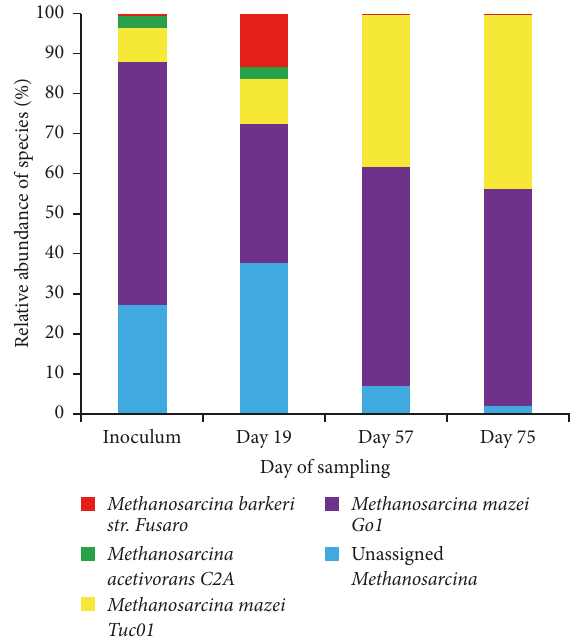
Figure 7: Dynamics of relative abundance of species members of Methanosarcinales order during the time course of microalgae and sodium acetate